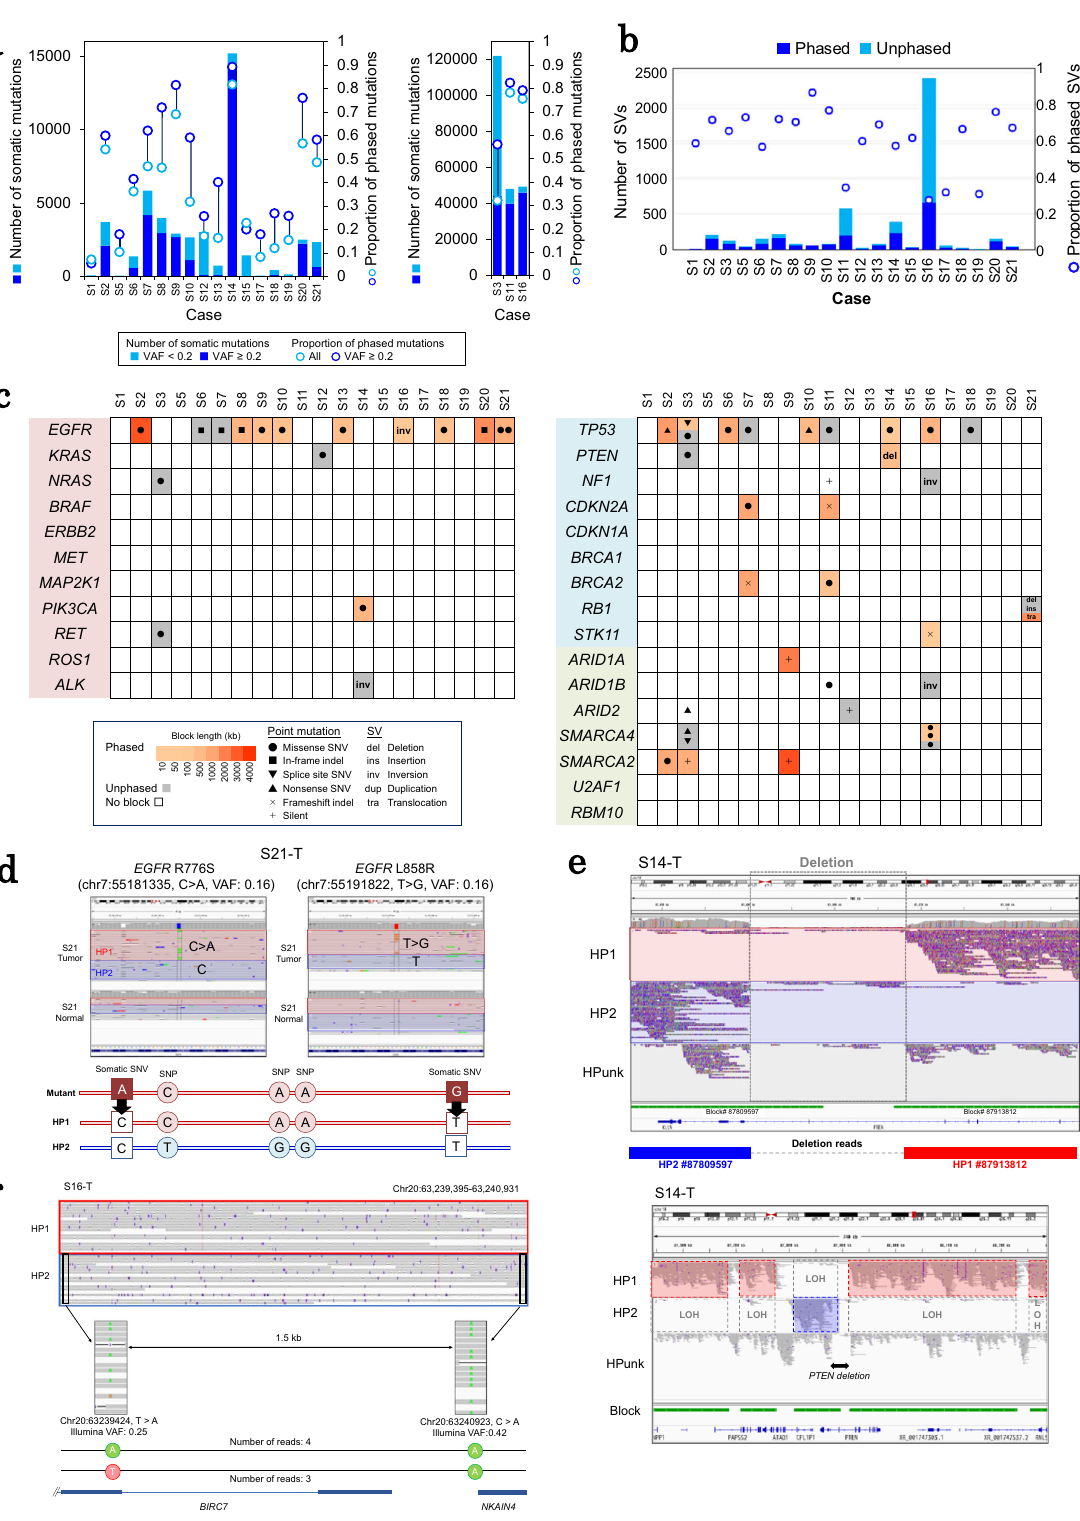
Fig. S11a). To examine the transcriptional consequences of the mutations in each haplotype, we performed long read RNA sequencing for six representative cancer specimens together with their normal counterparts (cases S1, S3, S6, S8, S10, and S20), for which high-quality RNA samples were available. Based on the SNPs represented on the RNA-seq reads, the haplotype origin of their transcripts was identi fi ed. When an